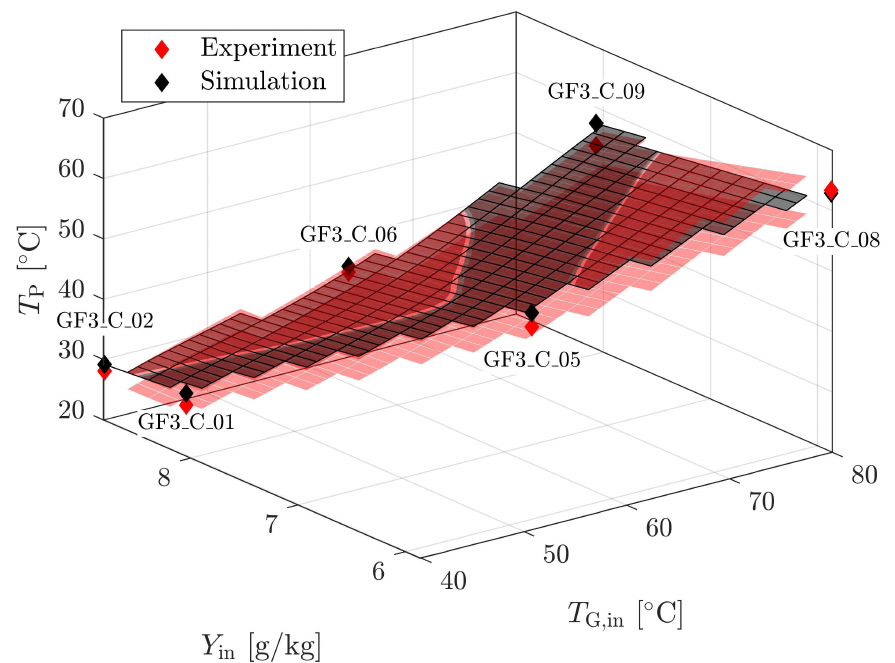
Figure 10. Comparison of measurements and model predictions of particle temperature ( T P ), plotted against drying temperature ( T G,in ) and inlet moisture content of air ( Y in ), in the GF3 lab-scale dryer for Cellets. The dark gray area designates model predictions; light red areas indicate the upper and lower boundary of measurement errors. Detailed information about the process conditions of the represented data points is given in Table